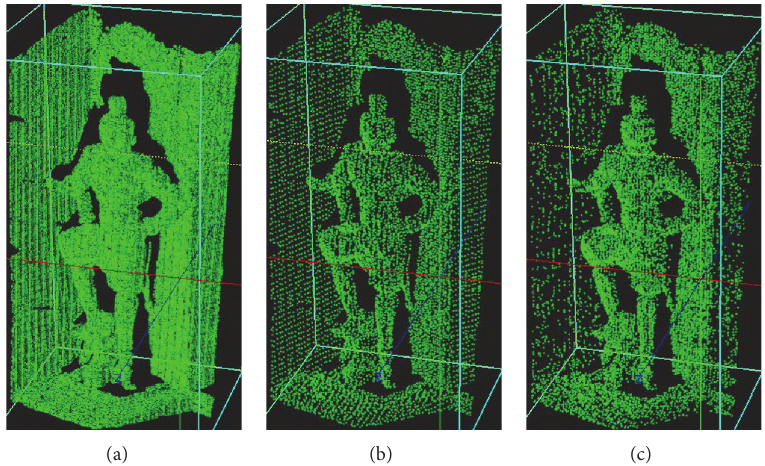
Figure 4: Point cloud data processing: (a) original data, (b) uniform sampling, and (c) nonuniform